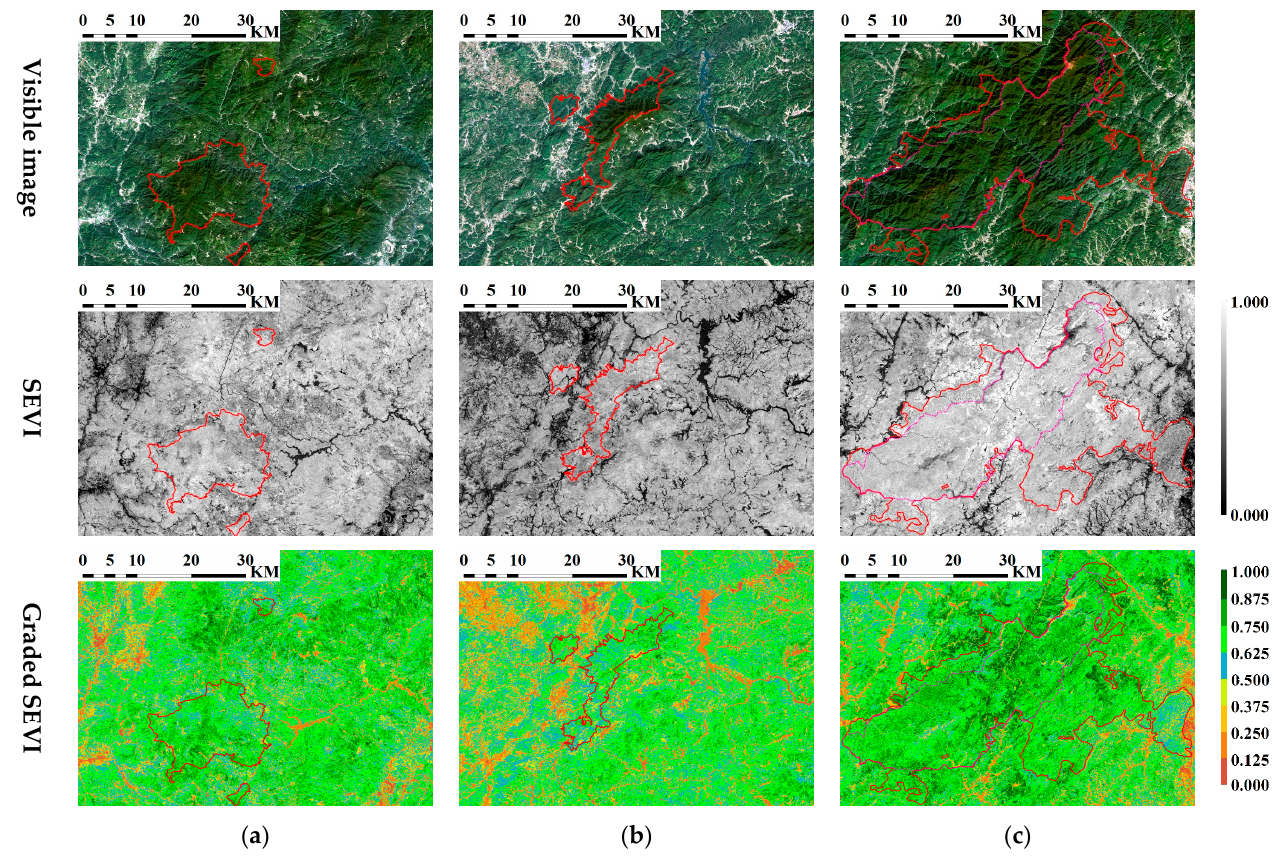
Figure 8. The visible image, and the SEVI and graded SEVI of protected areas: ( a ) MHS; ( b ) MJY; ( c ) WYS (red shape for national park, pink shape for national nature reserve).